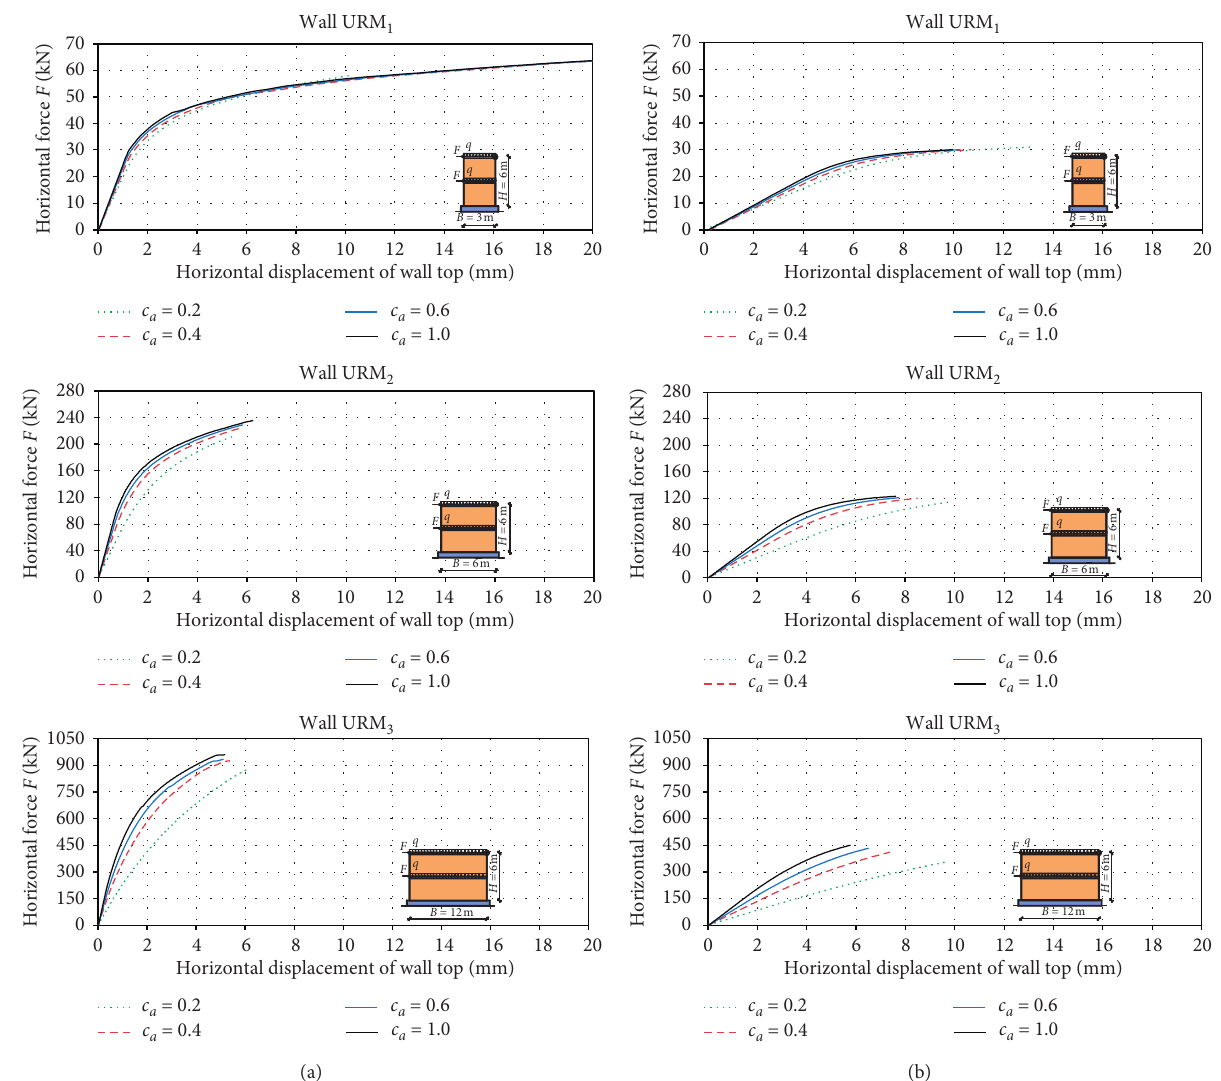
Figure 9: Horizontal displacement of the top of unreinforced masonry walls: (a) stiff masonry; (b) soft